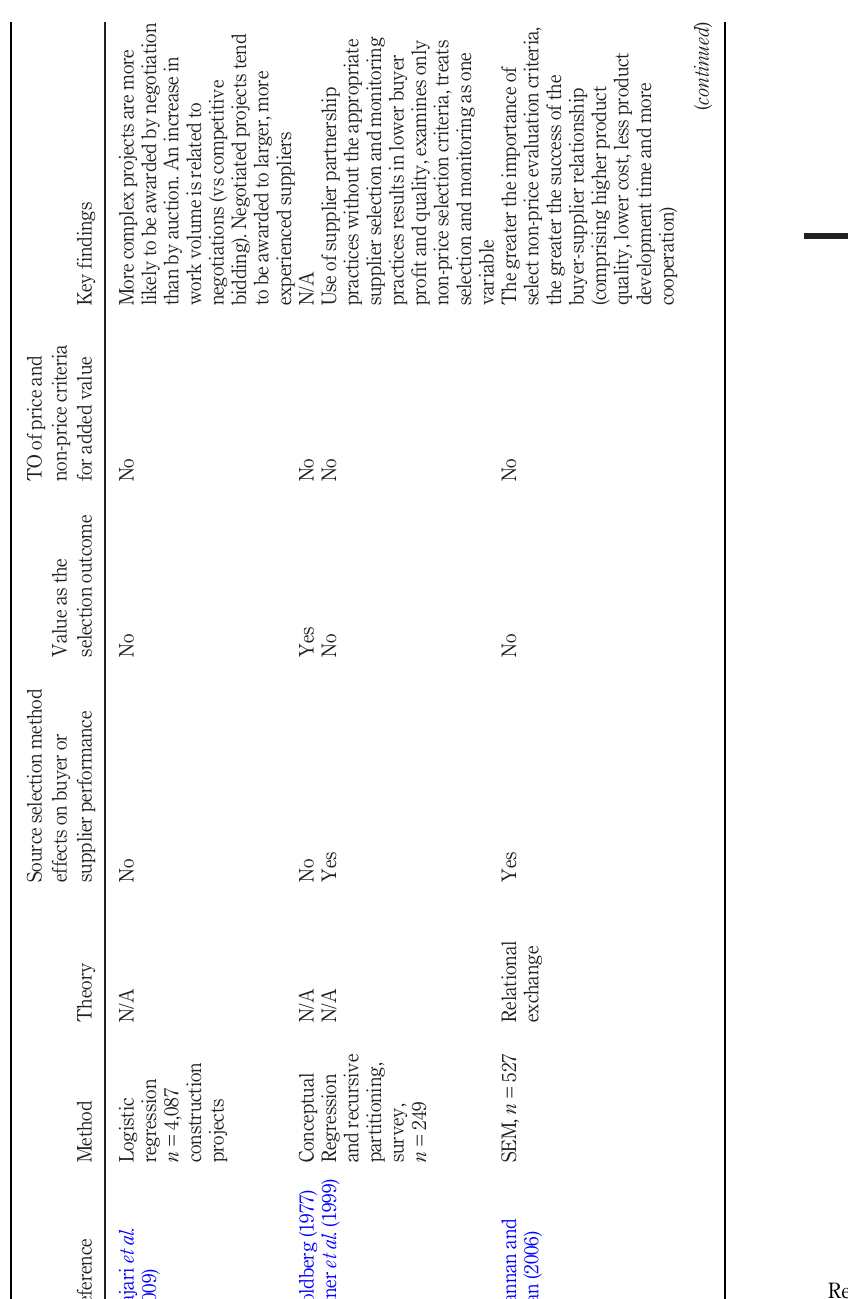
Table I. Relevant